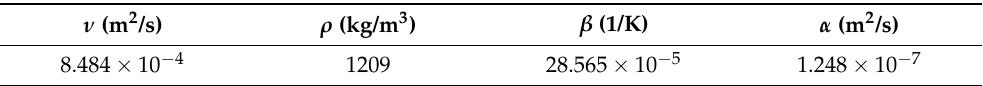
Table 1. Physical properties of 5% Fe 3 O 4